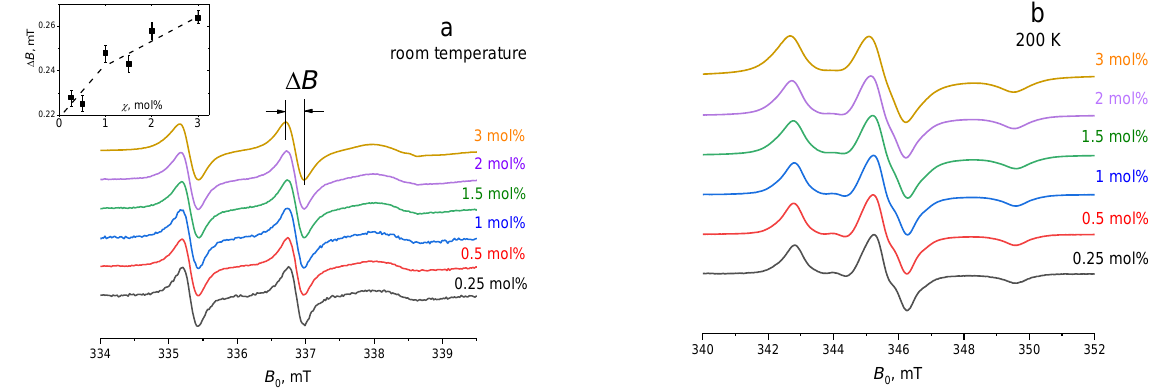
Figure 2. EPR spectra for different concentrations of ibuprofen-SL in POPC bilayer taken ( a ) at room temperature and ( b ) at 200 K. The insert shows the concentration dependence of the central component width at room temperature. The dashed line is drawn to guide the eye.